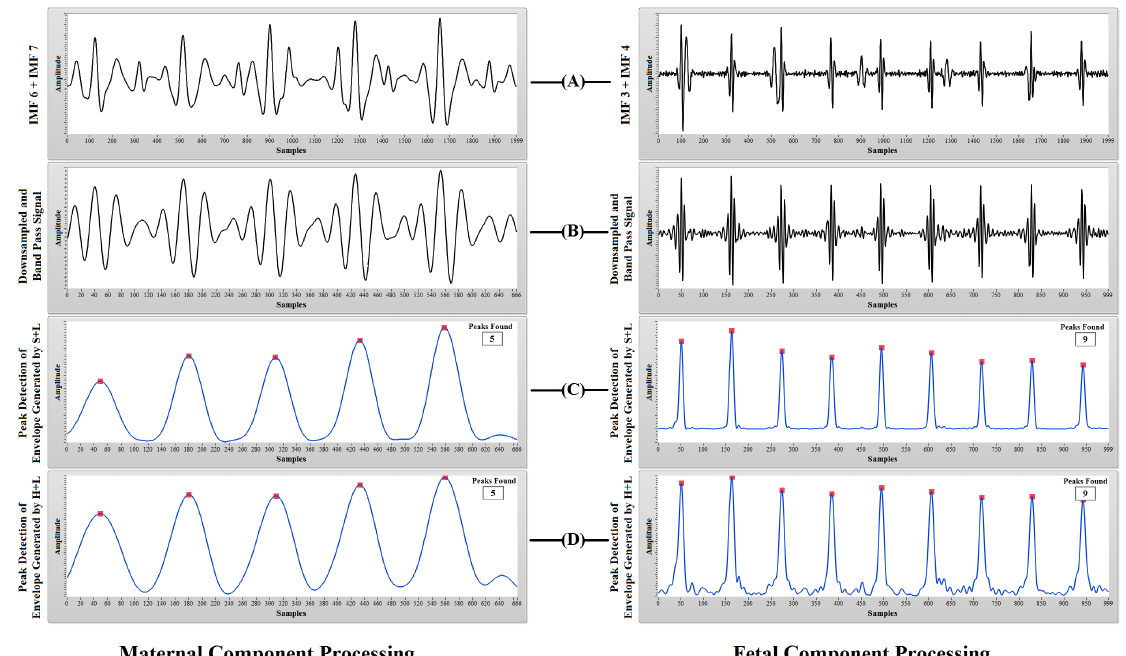
Figure 9. Synthetic aECG processing: ( A ) sum of the selected IMFs for probable MHR and FHR information; ( B ) downsampled and bandpass signal; ( C ) peak detection of the envelope generated using squaring and low-pass filtering (S+L); ( D ) peak detection of the envelope generated using Hilbert transform and low-pass filtering